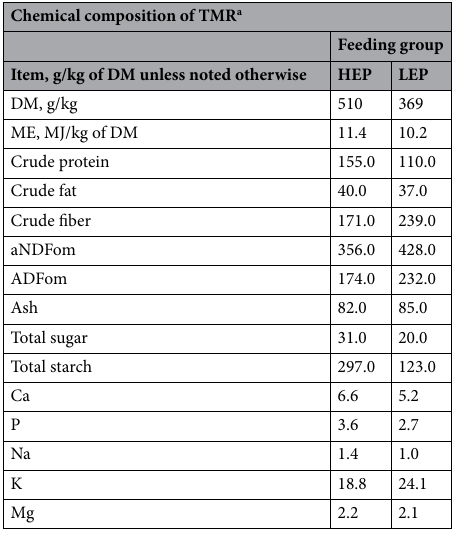
Table 2. Chemical composition of total mixed rations (TMR) fed during the experimental period. a DM dry matter, ME metabolizable energy, aNDFom neutral detergent fibre assayed with a heat stable amylase and expressed exclusive of residual ash, ADFom acid detergent fibre expressed exclusive of residual ash, HEP high energy and protein diet, LEP low energy and protein diet.